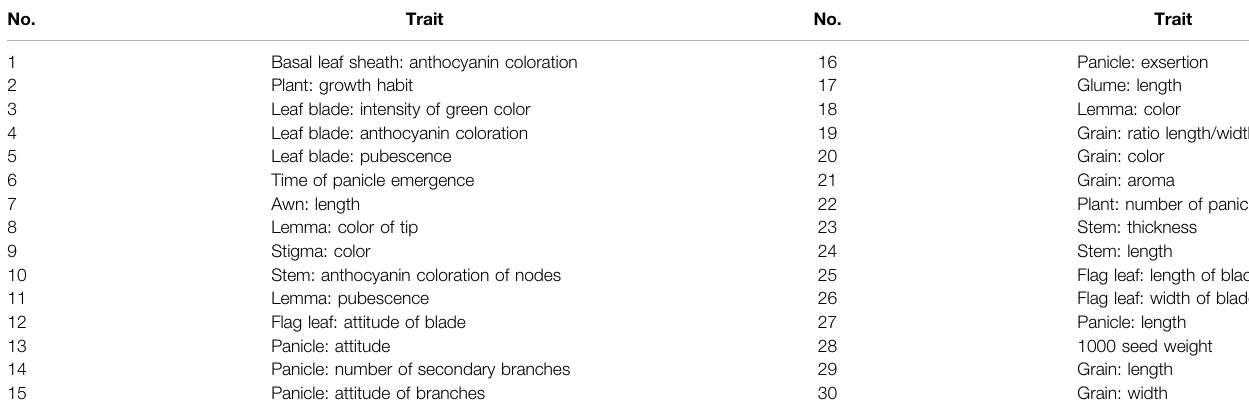
TABLE 2 | 30 Morphological traits used for the DUS testing of rice. No.